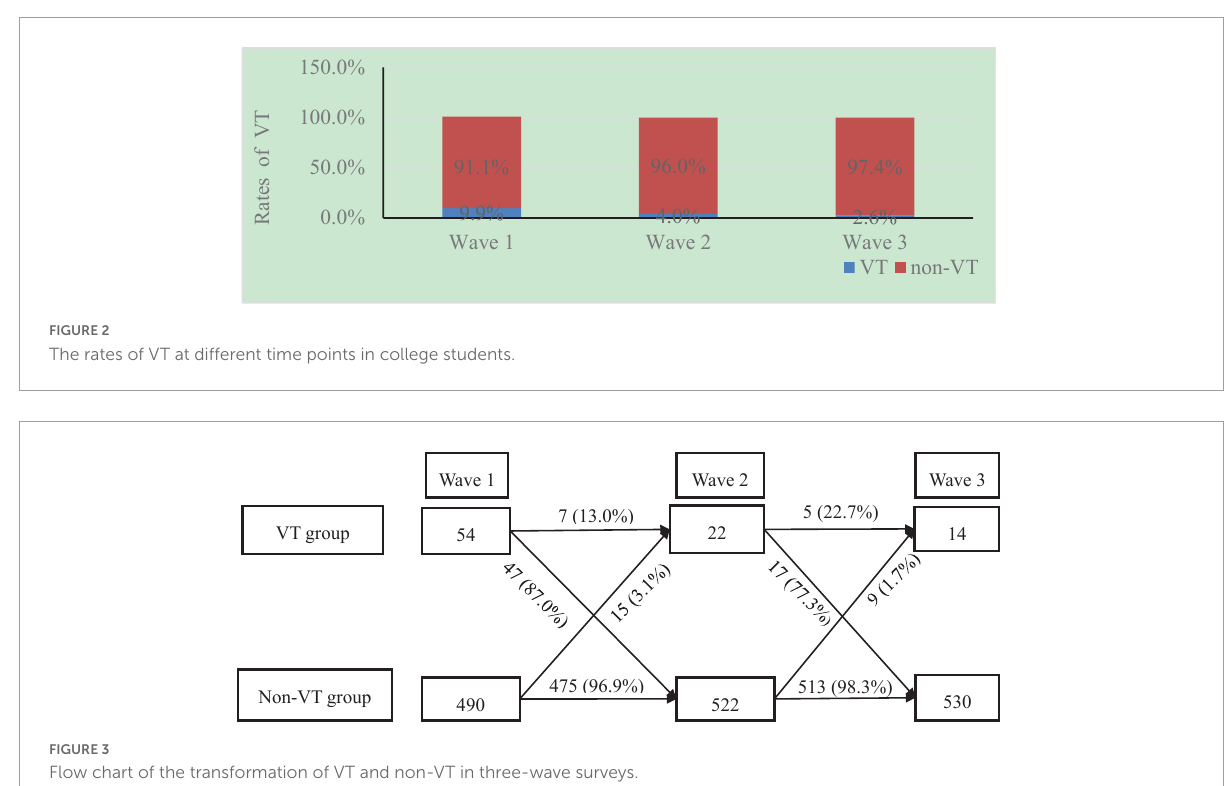
non-VT group, whereas nine from 522 students in the non-VT group changed to the VT